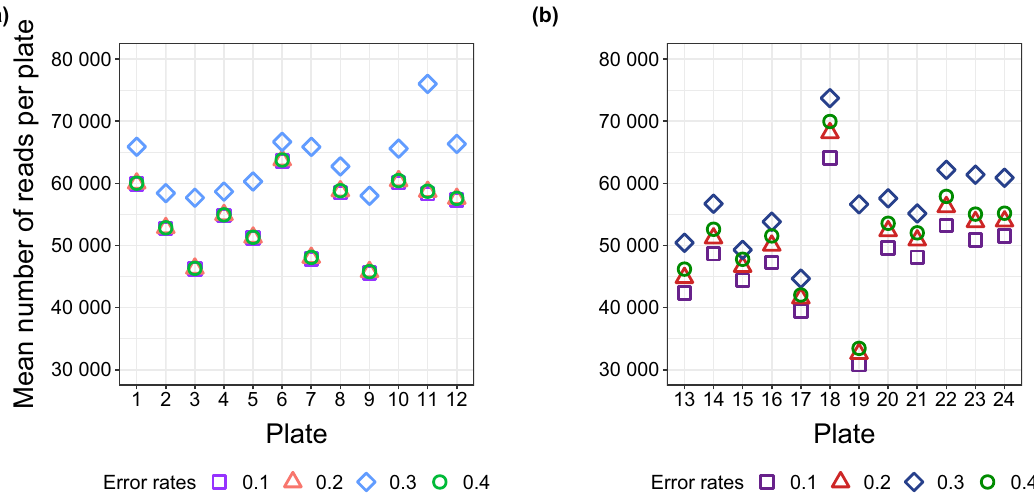
Figure 6. Comparison of changed error rates on the number of trimmed reads for plate samples of ( a ) Lane 1 and ( b ) Lane 2 by using the software